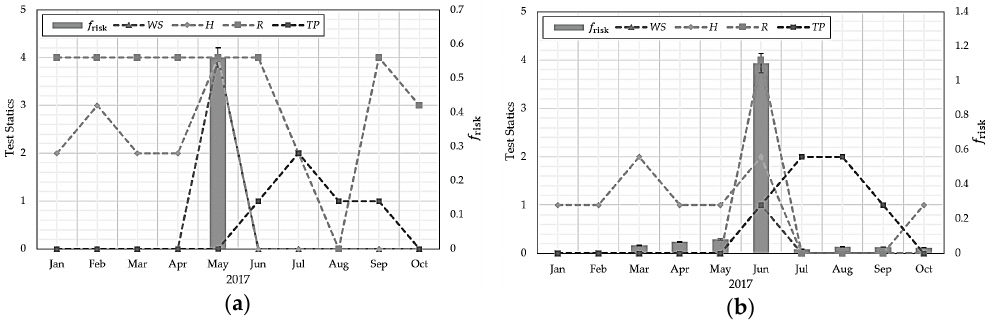
Figure 2. Test statistic variation with duty-cycle length for ( a ) Mt. Gangneung and ( b ) Mt. Surak.